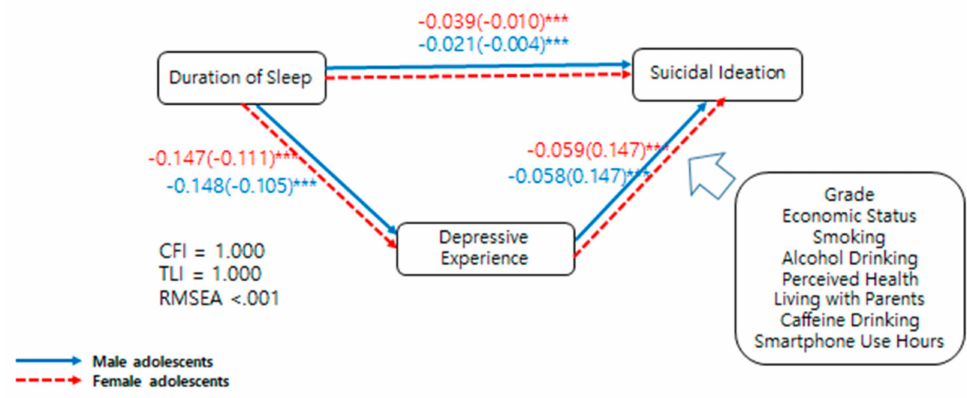
Figure 1. Standardized coe ffi cients (unstandardized coe ffi cients) of variables from the estimated structural equation model in male adolescents (blue line) and female adolescents (red line). CFI: comparative fit index; TLI: Tacker–Lewis index; RMSEA: root mean square error of approximation; *** appears statistically significant ( p <